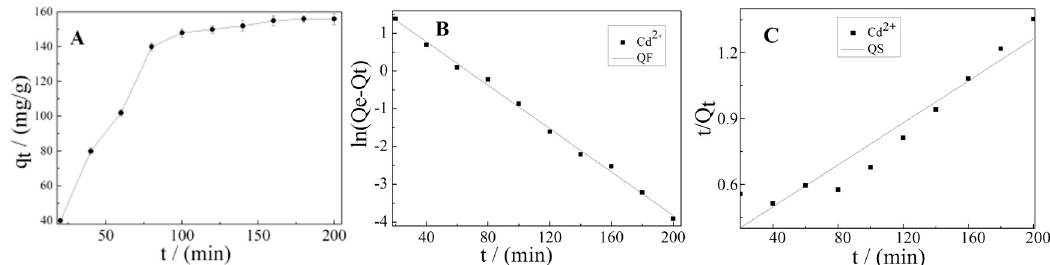
Figure 8. ( A ) Effect of contact time for Cd 2+ adsorption by K-Ac; ( B ) adsorption kinetics of Cd 2+ -fitted quasi-first-order rate model; ( C ) adsorption kinetics of Cd 2 -fitted quasi-second-order rate model. Table 2. The kinetic parameters of the quasi-first-order (QF) and quasi-second-order (QS) models on the adsorption of Cd 2+ .